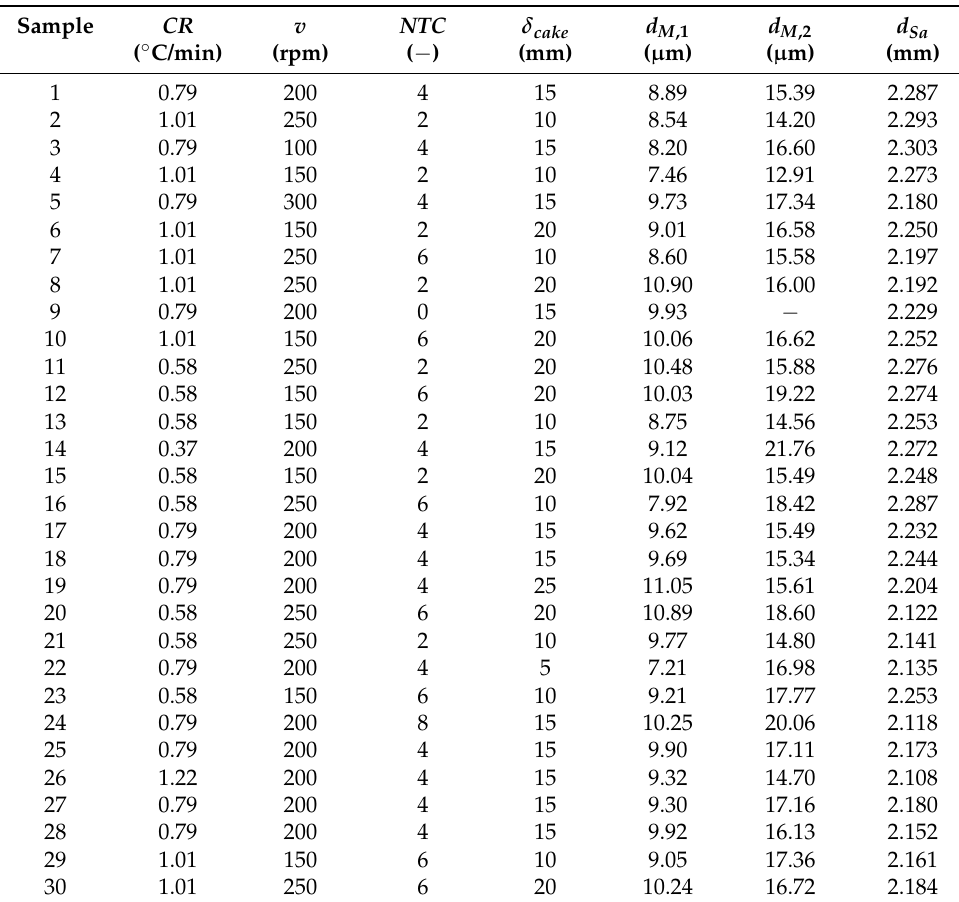
Table 1. Summary of structure-relevant parameters for